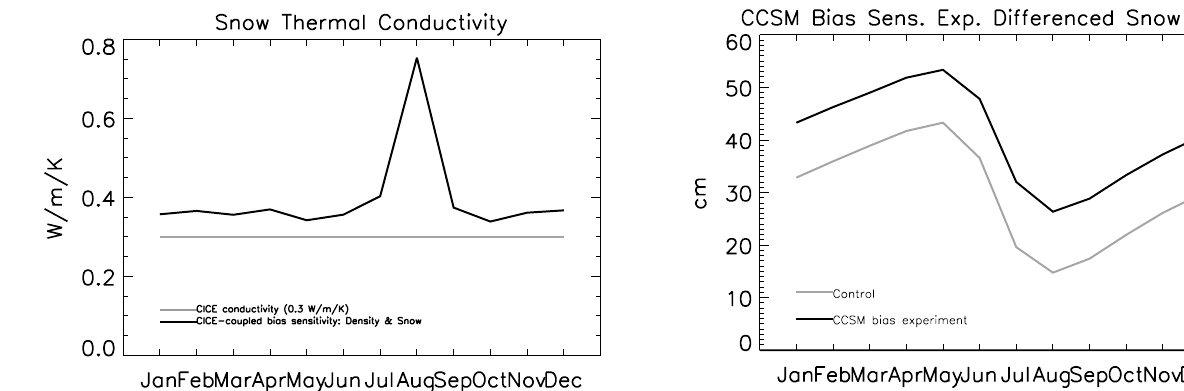
Fig. 4. Intrannually varying now conductivity adjustments, applied throughout the CCSM bias experiment.